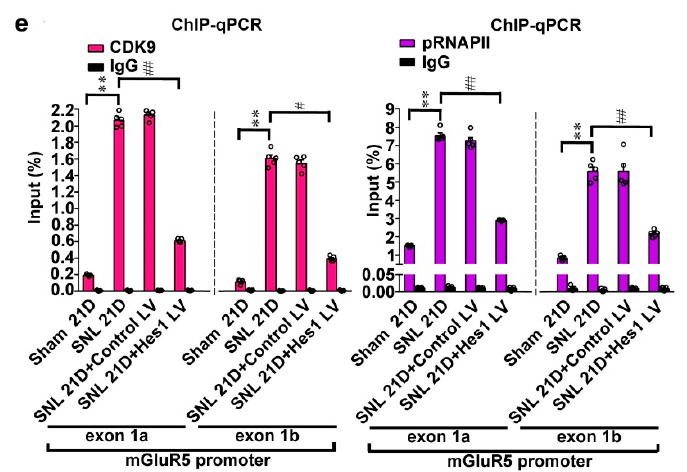
Figure 5. Neuropathic injury impedes Hes1 ‐ suppressed CDK9 recruitment and RNAPII phosphorylation on mGluR5 promoters. ( a ) Representative western blot and statistical analyses (normalized to GAPDH) of dorsal horn samples demonstrating the levels of CDK9 and phosphorylated RNAPII (pRNAPII) were increased by spinally administering naïve animals (Naïve) with Hes1 ‐ siRNA but not with missense siRNA (Hes1 siRNA and MS siRNA, respectively, 5 μ g, 10 μ L; daily for 4 days). IB, immunoblotting. CDK9, one ‐ way ANOVA, post ‐ hoc Tukey test, F (2,15) = 64.17, p < 0.0001. pRNAPII, one ‐ way ANOVA, post ‐ hoc Tukey test, F (2,15) = 59.83, p < 0.0001. ** p